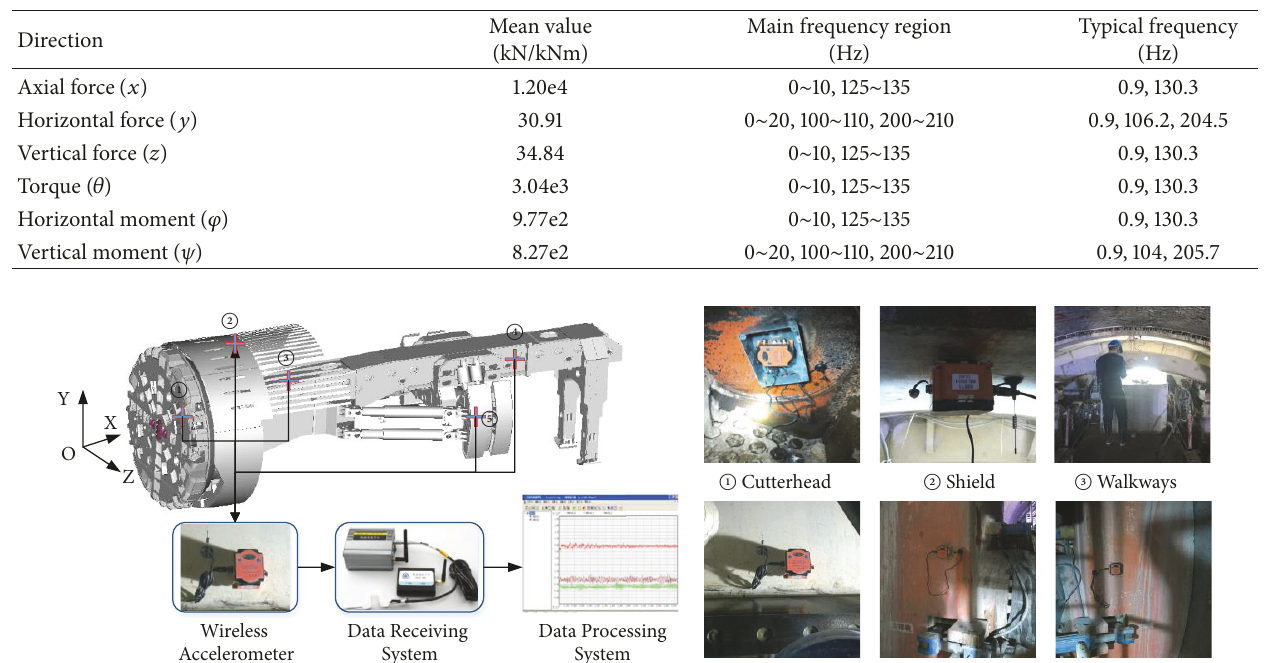
Table 1: Mean values and main frequencies of the simulated loads on the cutterhead.